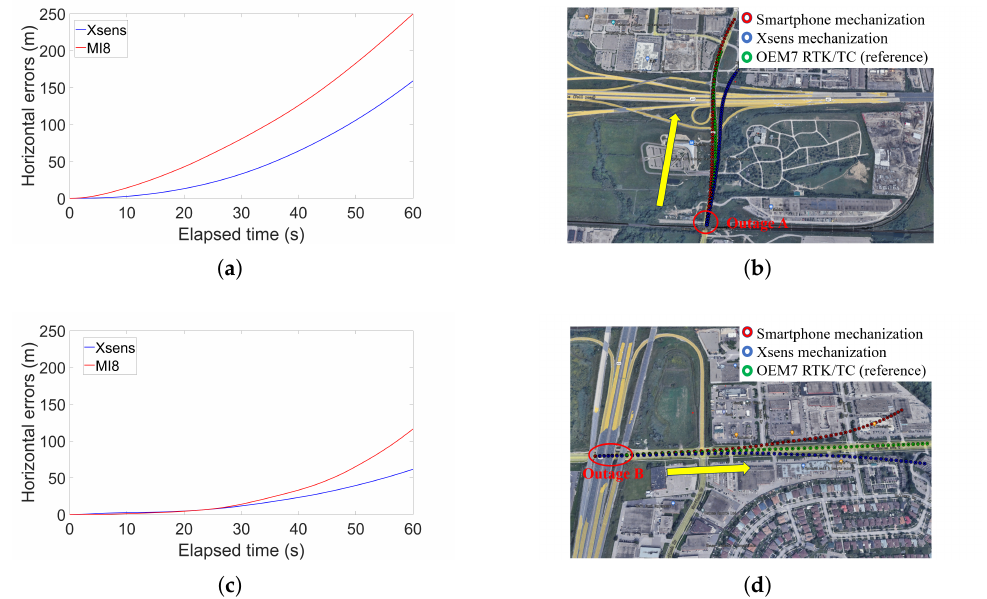
Figure 5. Position estimates based on dead-reckoning of Xsens and MI 8 IMUs only within 60 s. ( a ) IMU dead-reckoning horizontal errors within 60 s at Outage A. ( b ) Google Earth view of IMU mechanization trajectories at Outage A. ( c ) IMU dead-reckoning horizontal errors within 60 s at Outage B. ( d ) Google Earth view of IMU mechanization trajectories at Outage